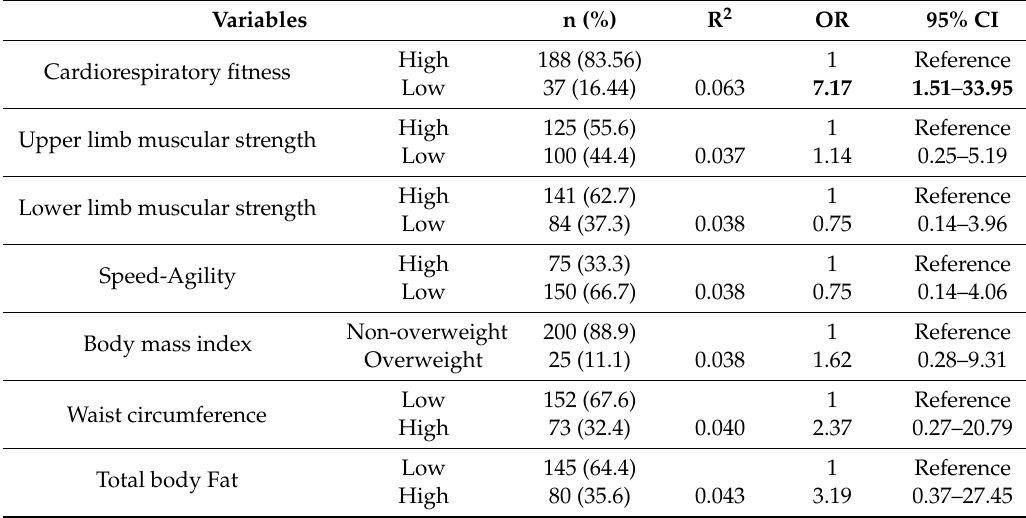
Table 3. Logistic regression analyses of health-related physical fitness components categories with self-rated risk of